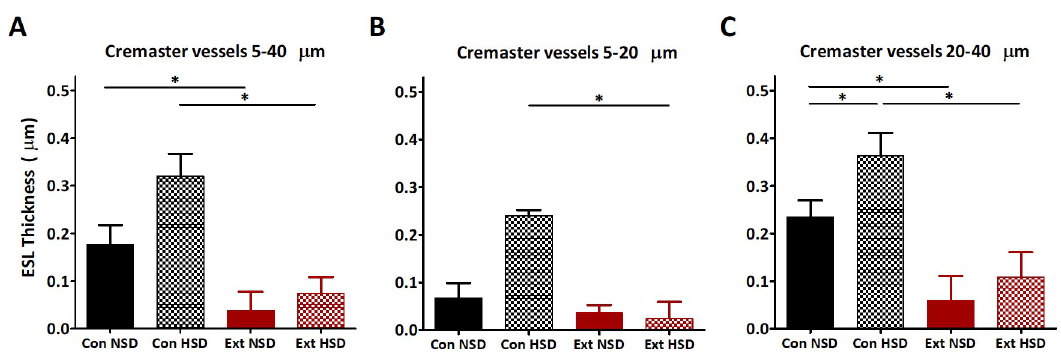
Fig 2. ESL thickness is reduced in Ext1 +/- Ext2 +/- mice and increased by high sodium diet. (A) Control mice had a larger ESL (NSD: 0.18 ± 0.04 μ m, n = 6; HSD: 0.32 ± 0.05 μ m, n = 3) than Ext1 +/- Ext2 +/- mice on both diets (NSD: 0.04 ± 0.04 μ m, n = 6, p = 0.04; HSD 0.07 ± 0.03 μ m,n = 7, p = 0.004). There was no difference in ESL thickness between diets within control mice (p = 0.07) or Ext1 +/- Ext2 +/- mice (p = 0.47). (B) In a subset of 5–20 μ m vessels with a mean diameter of 12.7 ± 0.8 μ m, control (0.07 ± 0.03 μ m, n = 4) and Ext1 +/- Ext2 +/- mice (0.04 ± 0.02 μ m, n = 5) had equal ESL thickness on a NSD (p = 0.38). On a HSD, control mice (0.24 ± 0.01 μ m, n = 3) had a thicker ESL than Ext1 +/- Ext2 +/- mice (0.02 ± 0.04 μ m, n = 7, p = 0.005). ESL thickness was not affected by diet within control mice (p = 0.06) or Ext1 +/- Ext2 +/- mice (p = 1.00). (C) In 20–40 μ m vessels with a mean diameter of 28.6 ± 0.4 μ m, controls (NSD: 0.24 ± 0.03 μ m, n = 6; HSD 0.36 ± 0.05 μ m, n = 3) had a significant larger ESL than Ext1 +/- Ext2 +/- mice on both diets (NSD: 0.04 ± 0.02 μ m, n = 6, p = 0.02; HSD: 0.11 ± 0.05 μ m,n = 7, p = 0.02). HSD increased ESL thickness in control mice (p = 0.02), but not in Ext1 +/- Ext2 +/- mice (p = 0.53). � p < 0.05. Con, controls; ESL, endothelial surface layer; Ext, Ext1 +/- Ext2 +/- ; HSD, high sodium diet; NSD, normal sodium